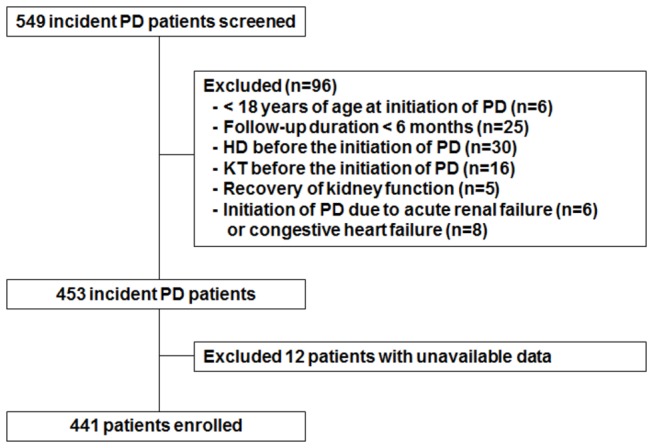
Flow chart of participants in the cohort.PD, peritoneal diaysis; HD, hemodialysis; KT, kidney transplant.